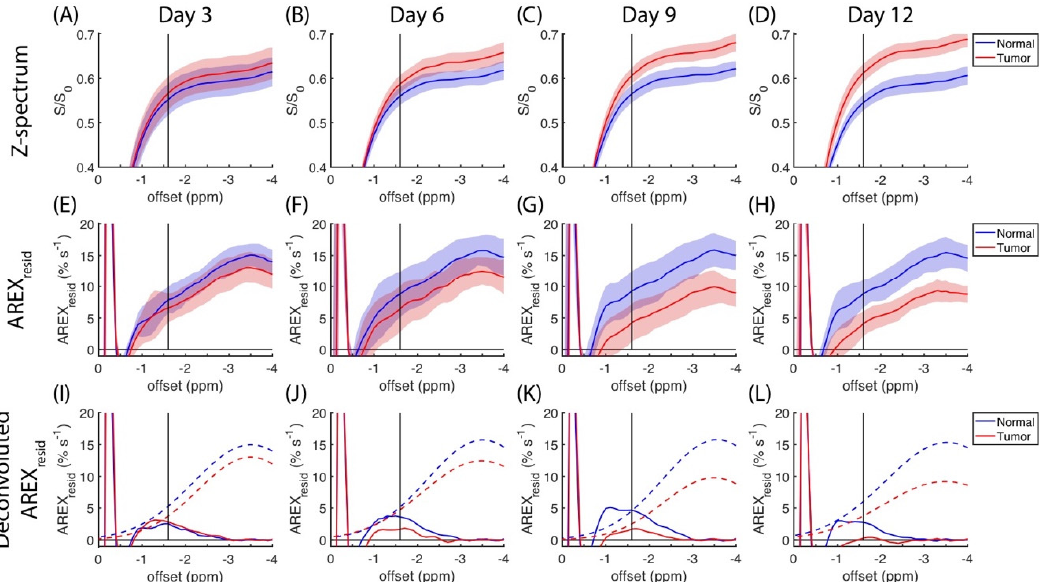
Figure 2. Expansion of z-spectra from Figure 1 for comparative purposes ( A – D ); the corresponding residuals of apparent exchange-dependent relaxation rate ( AREX resid ) are plotted from ( E – H ), which include averaged signals (N = 9) from normal (red) and tumorous (blue) brain tissues and their standard deviations (shaded areas). Averaged AREX resid signals from ( E – H ) are deconvoluted using a Gaussian function centered at approximately − 3.5 ppm ( I – L ), in which dashed lines indicate rNOE( − 3.5) and solid lines indicate residues from deconvolutions.